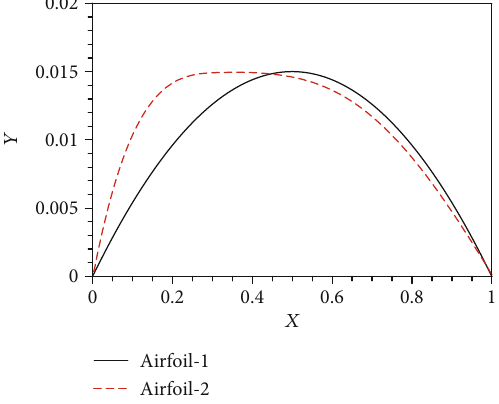
Figure 8: Supersonic airfoils.